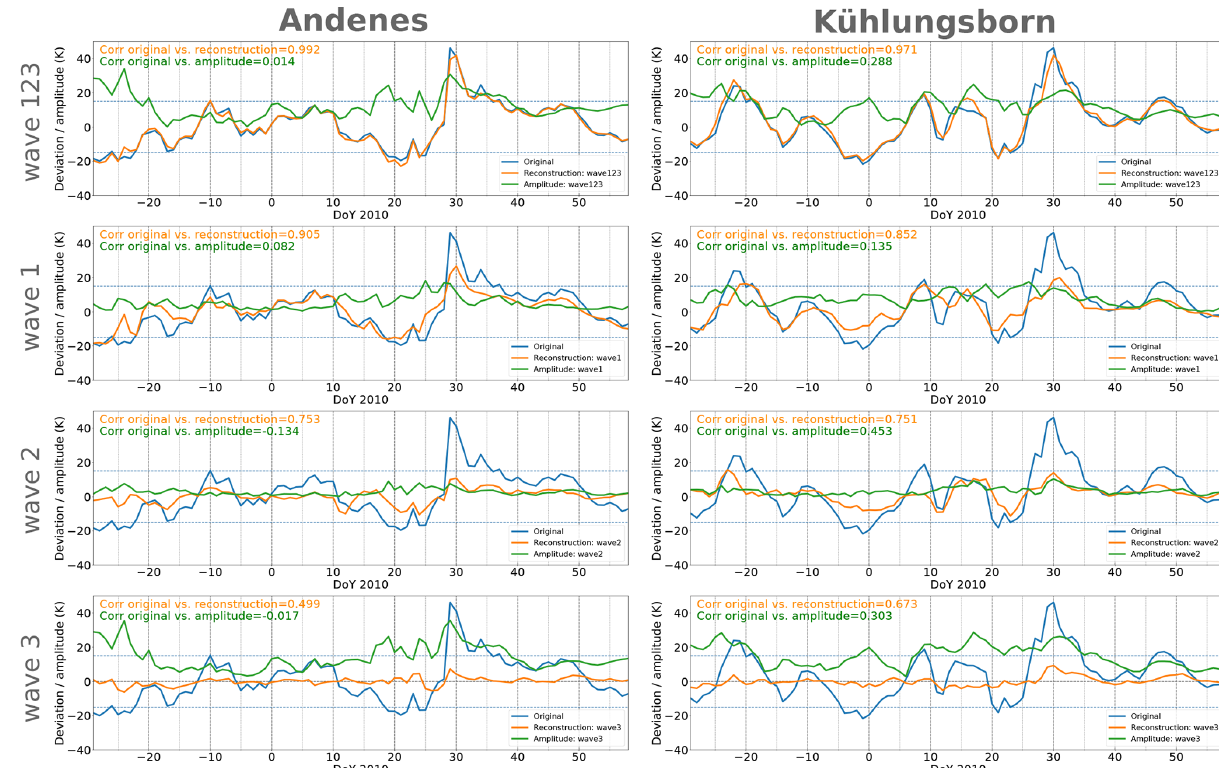
Figure 5. Temporal evolution of the temperature deviation from the climatological daily mean at Andenes (left) and Kühlungsborn (right) at 2hPa (blue line). The amplitude of each individual wave number (different rows) is represented by the green lines, while the local displacement, also called reconstructed time series, is represented by the orange lines. The horizontal grey dashed lines mark the positive and negative threshold of a STE. All data presented here are derived from MERRA-2 data.